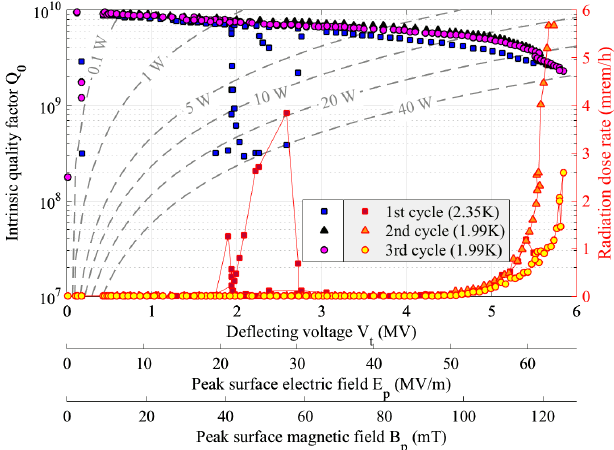
FIG. 11. Q 0 − V t curves and radiation measured during the cold test of cavity 1 at Jefferson